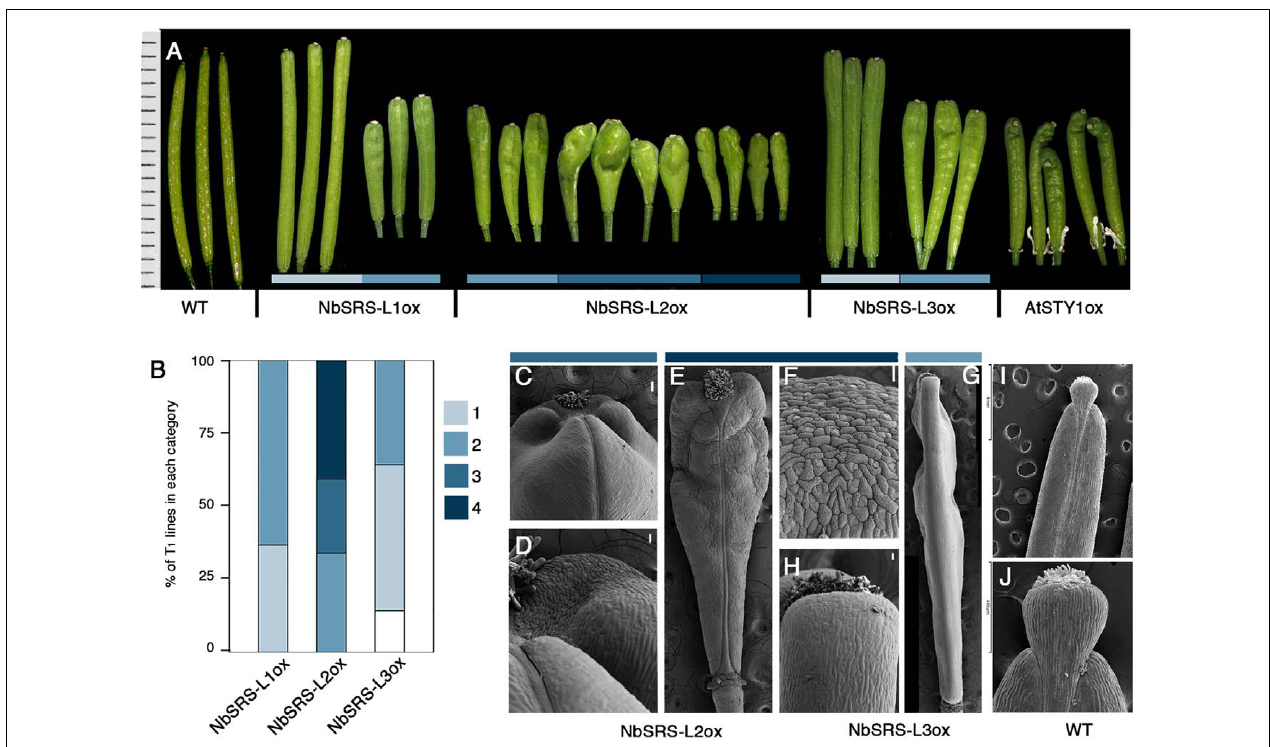
FIGURE 3 | Phenotypes of Arabidopsis transgenic lines overexpressing the NbSRS-L genes. (A) Three to five fruits from a single plant representative of the different phenotypic categories and genotypes are shown. The AtSTYox fruits belong to a transgenic line obtained from E. Sundberg’s lab (Kuusk et al., 2002). (B) Proportions of the different phenotypic categories among the T1 transgenic lines obtained for each construct, where 1 (light blue) represents the weakest phenotype and 4 (dark blue) the strongest phenotype. White color corresponds to plants showing no conspicuous differences respect to wild type. (C–J) Scanning electron micrographs of fruits from selected genotypes and categories. (C,D) Fruits from 35S::NbSRS-L2 lines in category 3. (C) Apical part of the fruit. (D) Close up of the style/valve area. While cells retain their identity, there is no clear demarcation between the two zones. (E) Fruit from a 35S::NbSRS-L2 line in category 4. (F) Close up of the apical part of the fruit shown in (E) . All the cells have a crenelated surface with the typical morphology of style cells and no valve cells can be distinguished. (G) Lateral view of a 35S::NbSRS-L3 fruit in category 2. The valves grow laterally to the same level as the stigma and style and have a square morphology. (H) Close up of the apical valve cells of the fruit shown in panel (G) . All cells have valve identity and no ectopic formation of style cells can be observed. (I) Wild type fruit. (J) Close up of the apical domain, where the demarcation of stigma, style, and valves is clearly seen. Bars in (C–G) : 50 µ